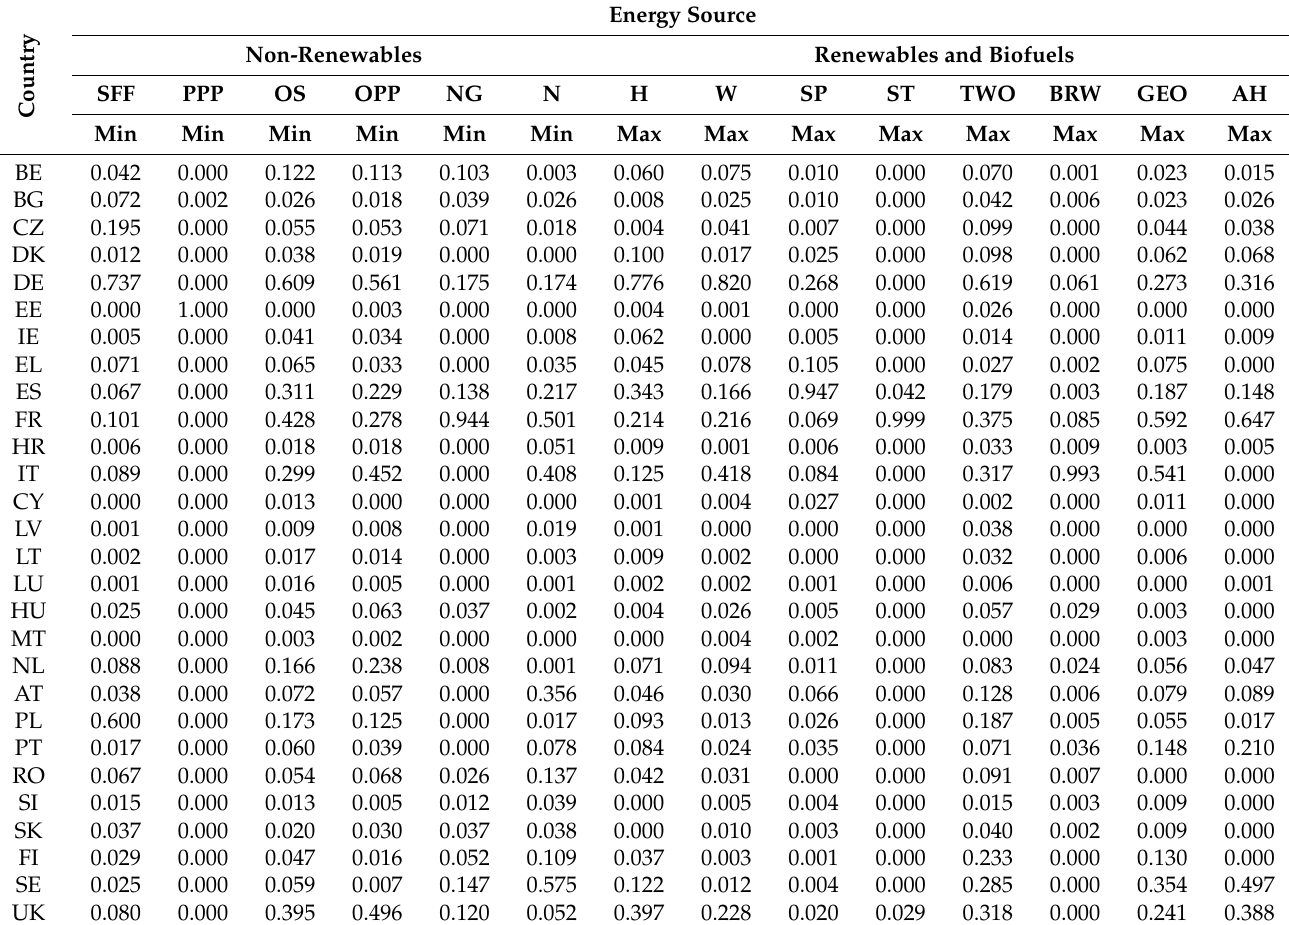
Table 3. Energy consumption in EU countries in 2019—normalization data.